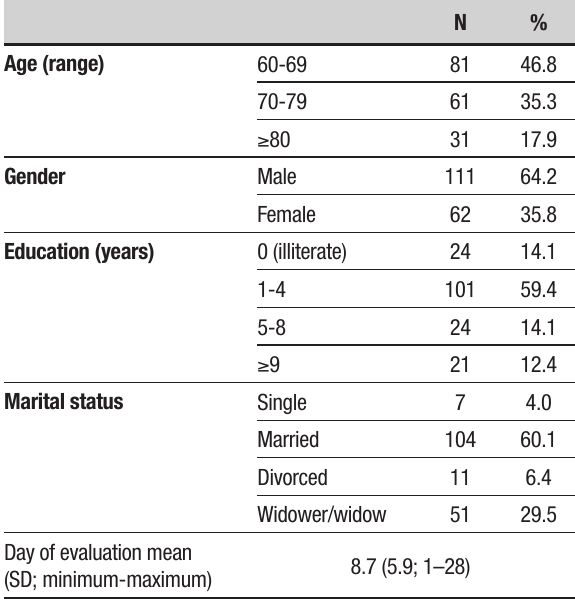
Table 1. Sociodemographic distribution of sample.